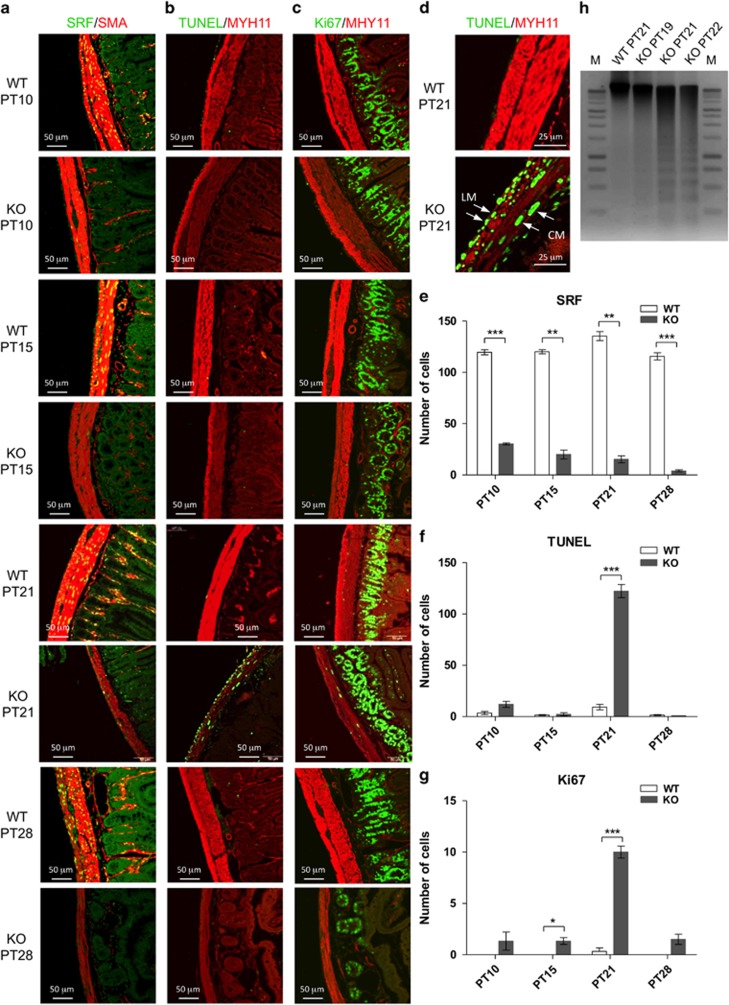
Increased apoptotic and proliferative activities as SRF depleted in Srf KO SMCs. (a) Cryosection images of jejunum showing gradual depletion of SRF (green, nucleus) and reduction of SMA (red, cytoplasm) in KO SMCs compared with WT control at 10, 15, 21 and 28 days post-tamoxifen injection (PT10–PT28). (b) Cryosection images of PT10–PT28 showing reactivity of TUNEL (green, nucleus), which was significantly increased in KO SMCs at PT21, compared with WT control. Expression of MYH11 (red, cytoplasm) was significantly less in apoptotic SMCs. (c) Cryosection images of PT10–PT28 showing reactivity of Ki-67 (green, nucleus), which was slightly increased in KO SMCs at PT21, compared with WT control. Expression of MYH11 (red, cytoplasm) was significantly less in KO SMCs. (d) High-magnification images of TUNEL reactivity in longitudinal (LM) and circular muscle (CM) layers at PT21 of KO and WT. Quantification of SRF+ cells (e), apoptotic (TUNEL+) cells (f) and proliferating (Ki-67+) cells (g) in the jejunal muscle layers of KO and WT in cryosection images (a–c) of PT10–PT28 (each n=3). Values are expressed as means±S.E. *P<0.01, **P<0.001, ***P<0.0001 versus WT. (h) Analysis of apoptotic DNA. Genomic DNA (500 ng of each) isolated from PT19, PT21 and PT22 of WT and/or KO was analyzed on a 1% agarose gel with a 10-kb DNA ladder